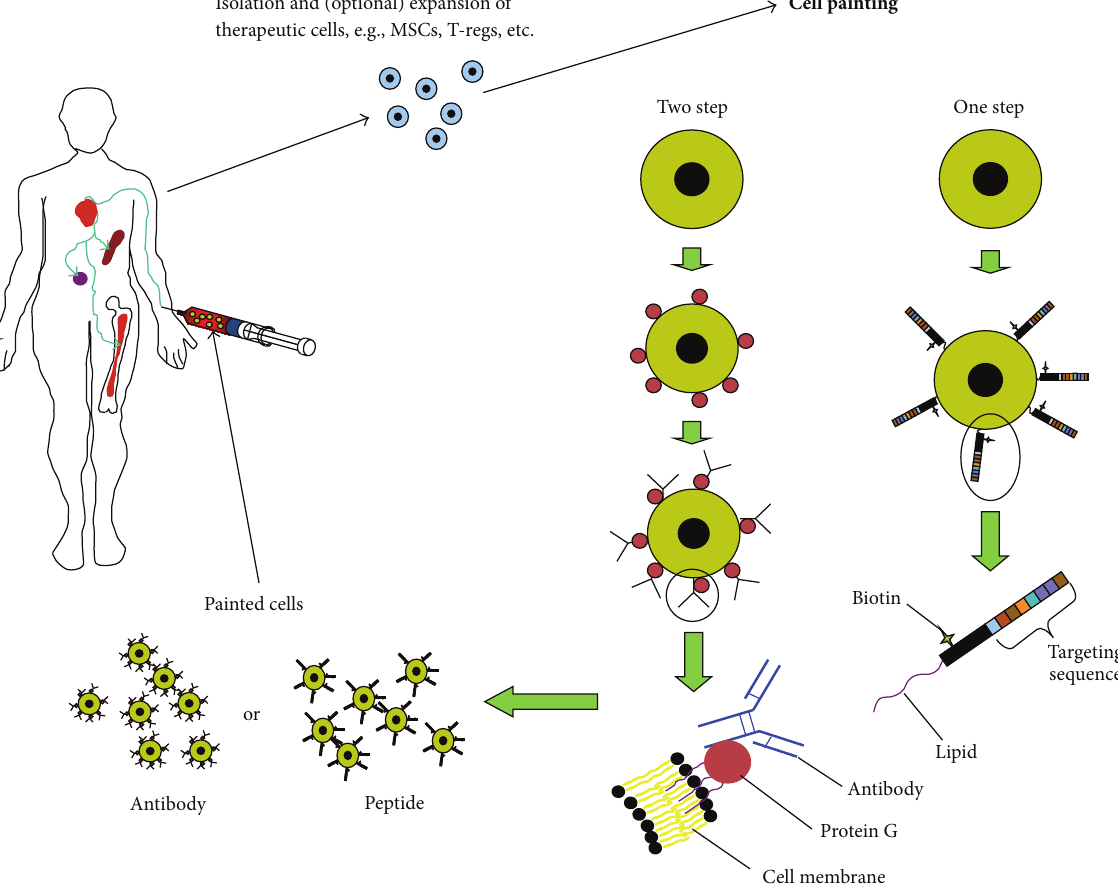
Figure 2: Antibody- and peptide-based cell painting. Therapeutic cells are harvested and “painted” either by a two-step process where the cells are first coated with lipidated protein A (or G) and then incubated with targeting antibody, or a one-step process where the cells are coated with a peptide-targeting molecule that contains a lipid moiety. The coated cells are then reintroduced into the patient where the cells are directed towards specific tissues or